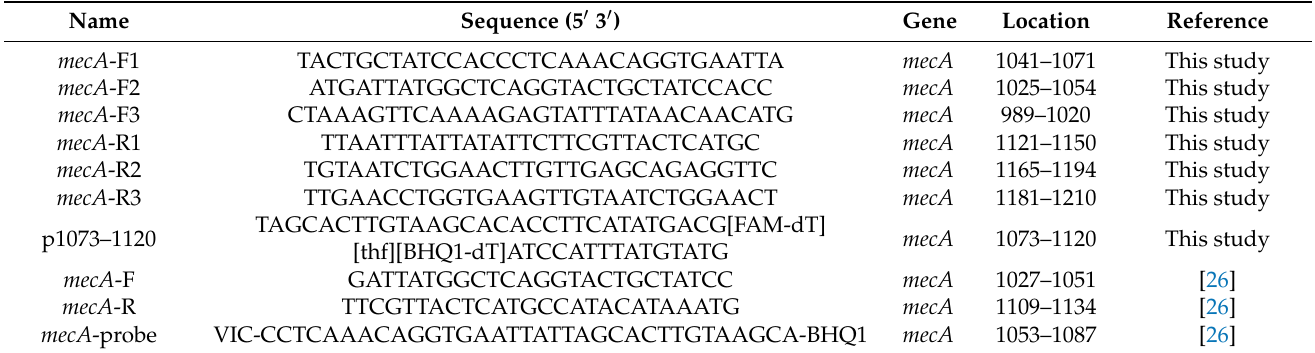
CTAAAGTTCAAAAGAGTATTTATAACAACATG mecA -R1 TTAATTTATTATATTCTTCGTTACTCATGC